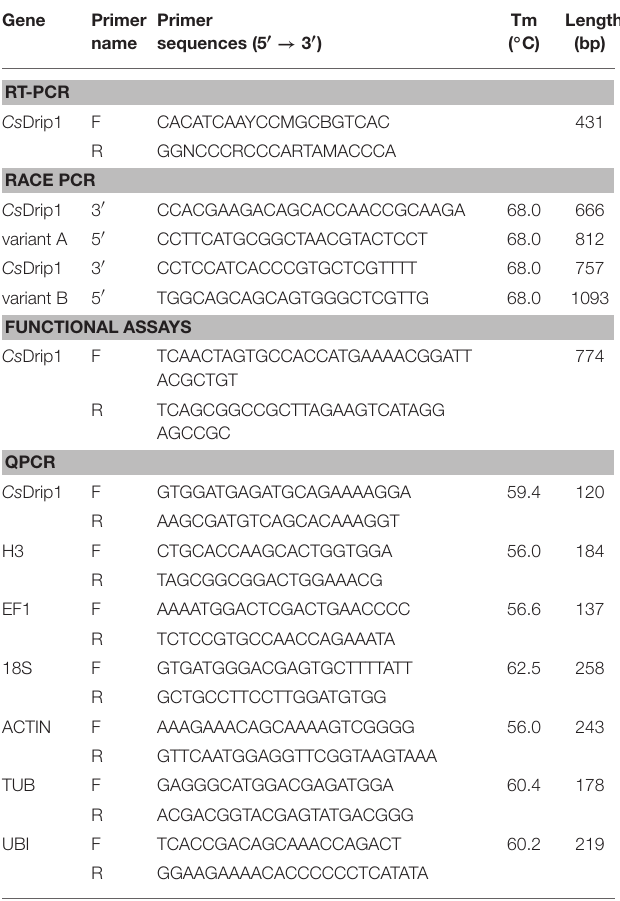
TABLE 1 | Primers used in this